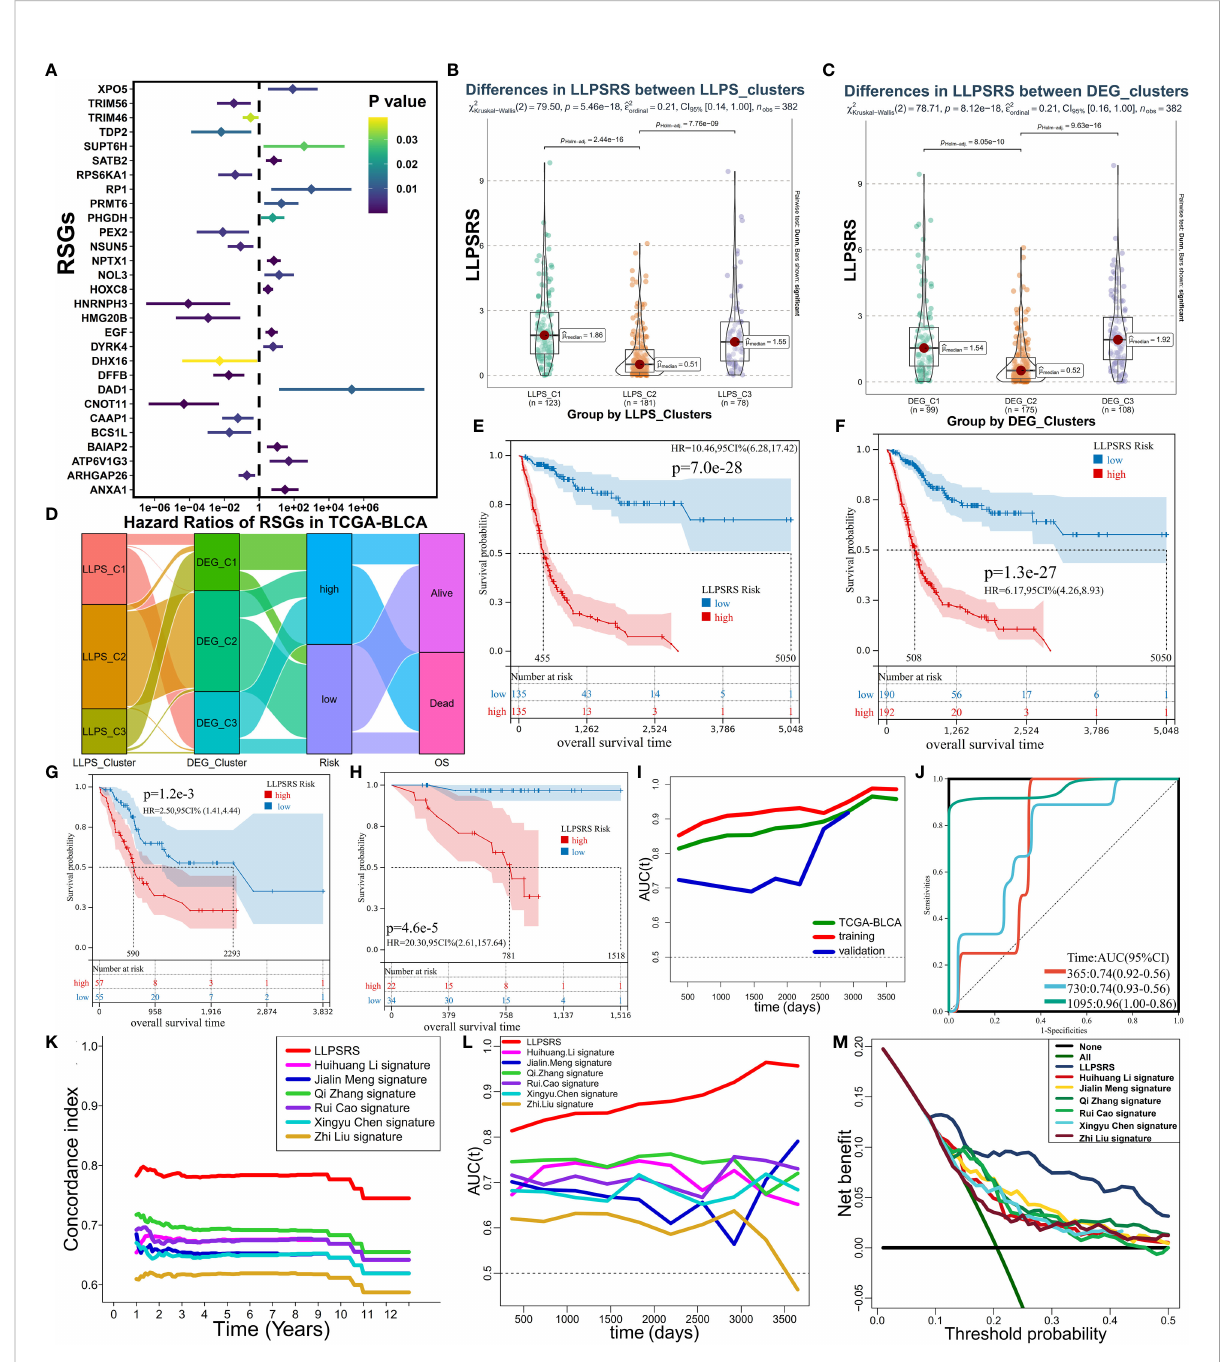
FIGURE 4 Establishment and evaluation of LLPSRS. (A) Forest plot of hazard ratios with 95% CI for 29 RSGs by univariate Cox. (B) Sankey diagram showing the changes of LLPS, DEG clusters, risk, and OS in TCGA-BLCA cohort. (C, D) Comparison of LLPSRS among LLPS and DEG clusters. (E – H) KM curves of LLPSRS in the training, TCGA-BLCA, validation, and GSE188715 cohorts. (I) Time-dependent ROC – AUC values plotted for different durations of survival for LLPSRS in the training, TCGA-BLCA, and validation sets. (J) ROC curves of LLPSRS in GSE188715 cohort. (K – M) Time- dependent C-index, ROC – AUC, and DCA showing a measure of LLPSRS with six prognostic signatures with the survival of patients in TCGA- BLCA cohort. LLPSRS, liquid – liquid phase separation-related risk score; DEG, differentially expressed gene; OS, overall survival; LLPS, liquid – liquid phase separation; KM, Kaplan – Meier; ROC, receiver operating characteristic; AUC, area under the receiver operating characteristic curve; DCA, decision curve